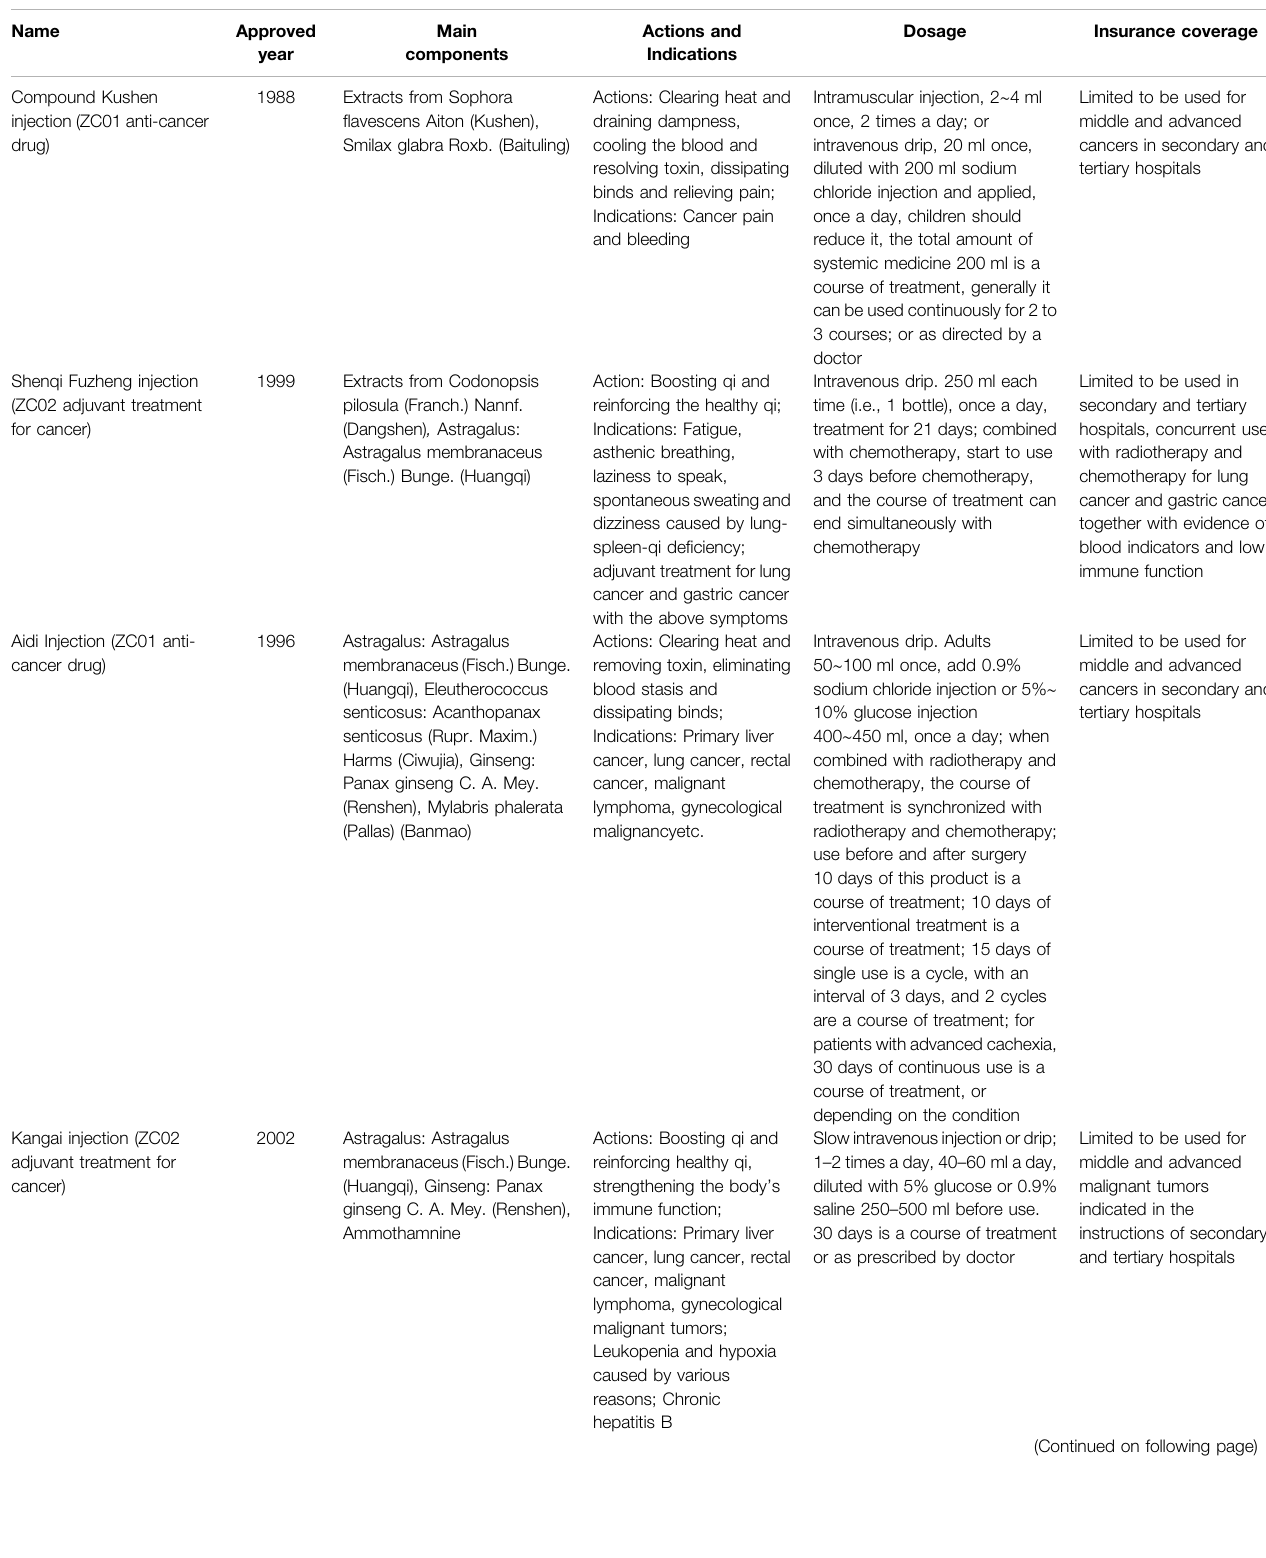
TABLE 1 | The basic information for ten Chinese herbal injections for cancer covered in the National Essential Health Insurance